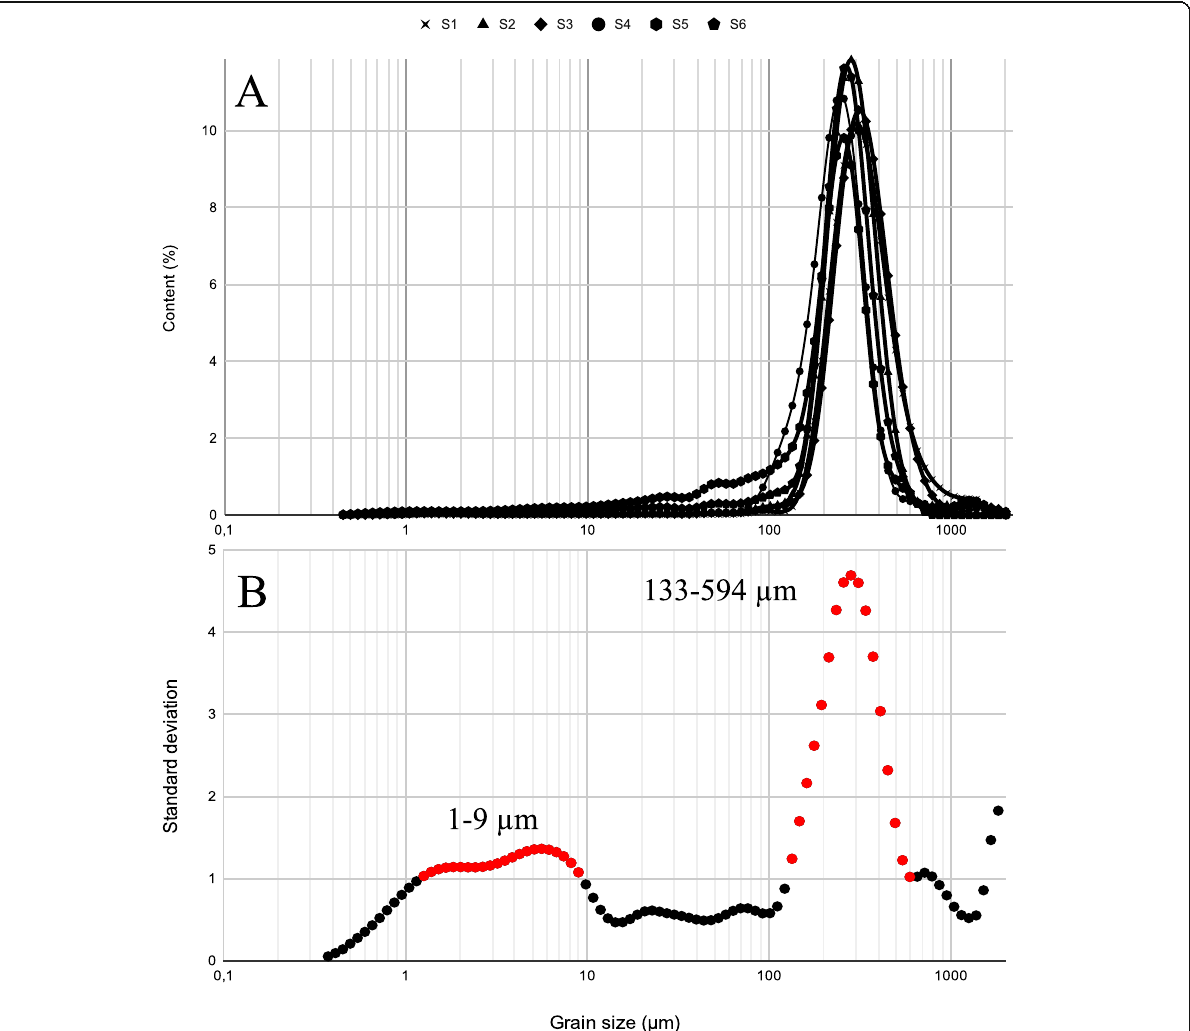
Fig. 5 a Grain size measurements of costal surface samples. b Standard deviation values vs. grain size classes of core TAH17 – 1 with red dots representing populations with the highest variability between 1 and 9 μ m and between 133 and 594 μ